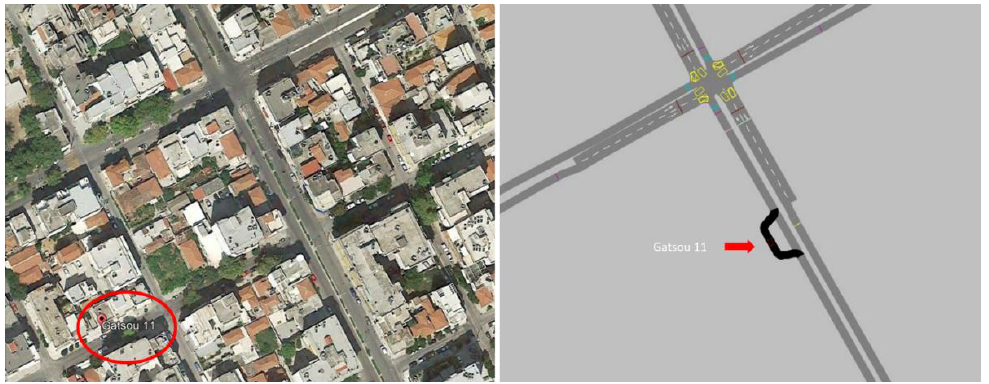
Figure 4. Isochrones map showing 1.5- and 3-min walking distances from (A), (B) and (E). Figure 4. Delivery stops in their actual position ( left , Google maps) and delivery stops as modeled ( right , PTV